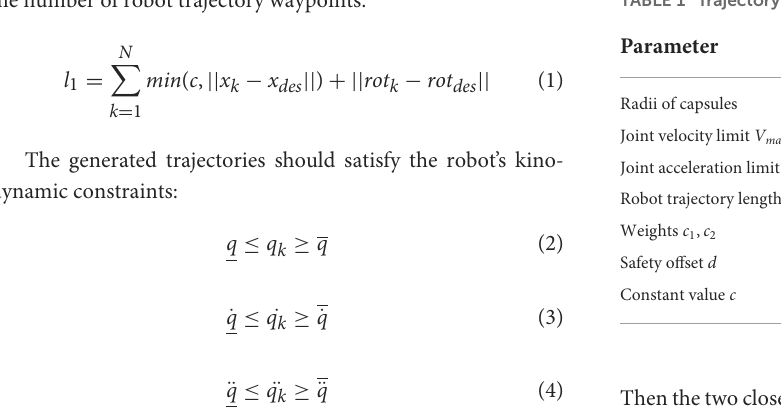
the number of robot trajectory waypoints. TABLE 1 Trajectory optimizer